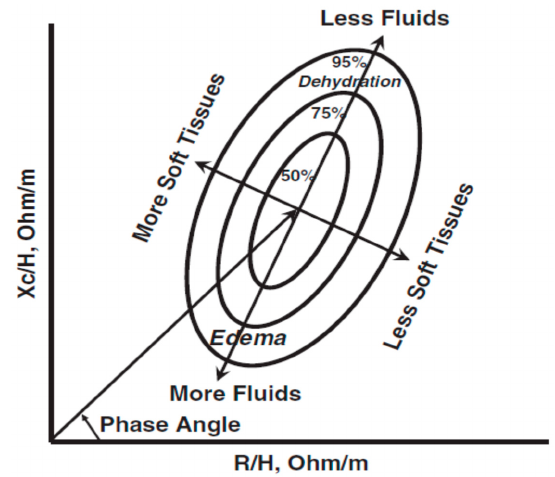
Figure 5. Resistance-reactance (RXc) plot with tolerance ellipses from healthy Caucasian males.